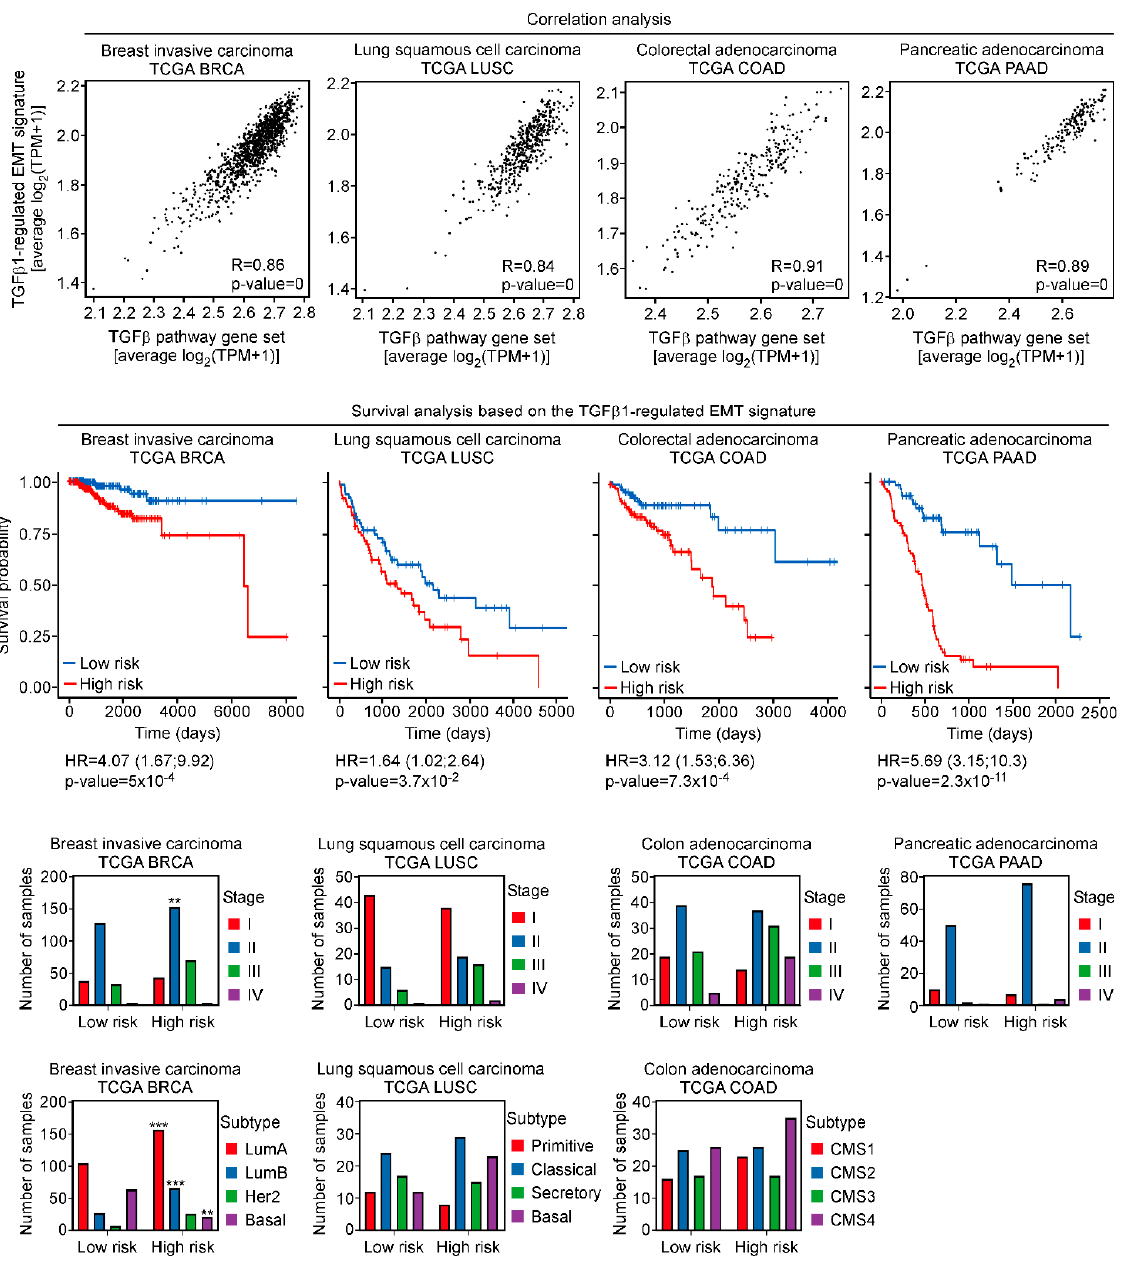
Figure 8. The TGF β -regulated EMT signature can be predictive for patient survival across cancer types. ( a ) TCGA RNA-seq datasets were used to calculate the correlation between the average expression of the TGF β -regulated EMT signature and the average expression of the REACTOME gene set “Signaling by TGF beta receptor complex” in breast invasive carcinoma (BRCA), lung squamous cell carcinoma (LUSC), colon adenocarcinoma (COAD), and pancreatic